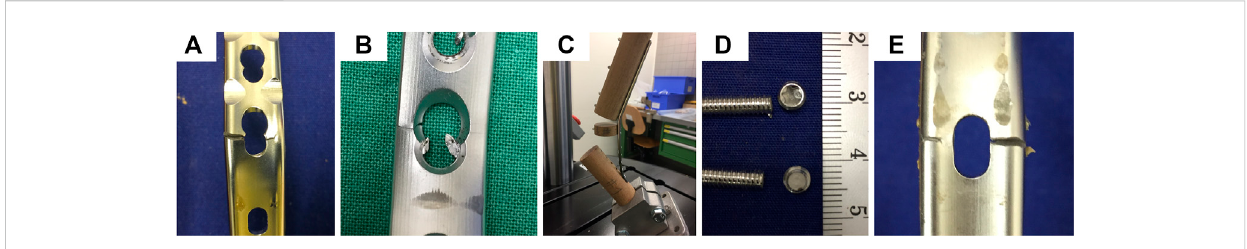
FIGURE 5 Photographsvisualizingfailuremodesafterfatiguetesting; (A) asymmetricplatefracturethroughthelockingpartofadistalradialcombinationhole, posterior view; (B) asymmetric plate fracture through the compression part of a distal radial combination hole, anterior view. Debris in the locking part indicate fractured screw; (C) excessive plate bending at the most distal screw hole following 1st and 2nd metacarpal screw breakage, lateral view; (D) breakage of 3rd and 4th (distal) radial screws attheir head-shaft interface, with numbers indicating length scale in centimeters; (E) asymmetric plate fracture through the radiocarpal hole, posterior